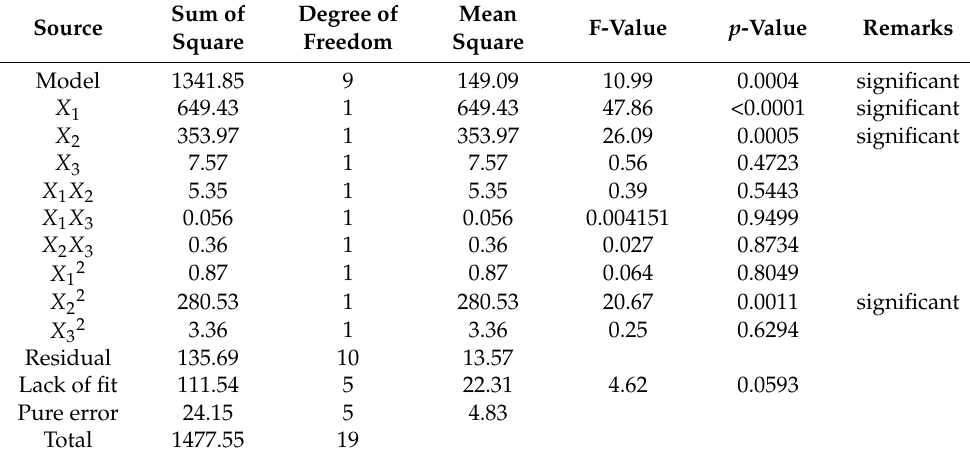
Table 4. ANOVA for response surface model of glucan content (GC).